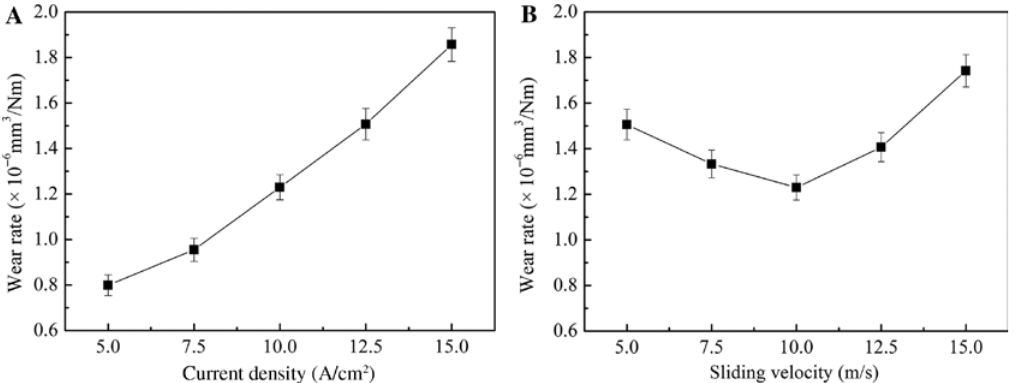
-graphite-multi-wall WS 2